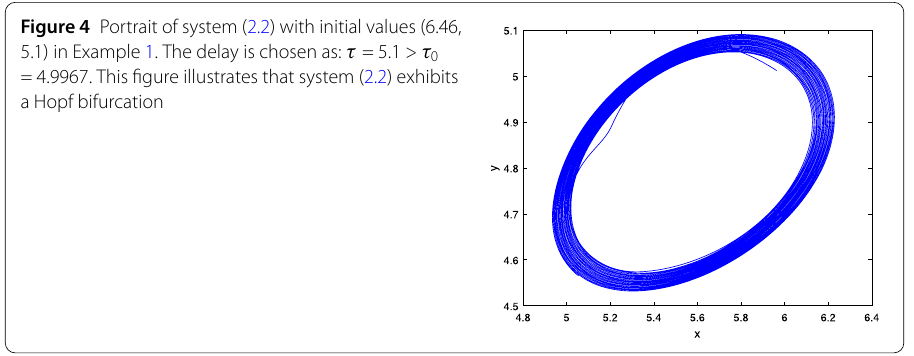
and critical frequency ω ∗ 0 0 and critical 0